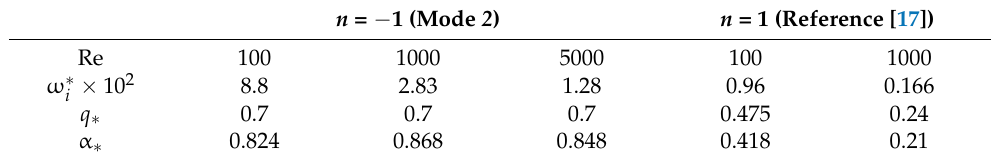
Figure 2. ( a ) The growth rate (solid lines) and oscillation frequency (dashed lines) vs. the wavenumber for Re = 100, q = 0.3; 0.4; 0.5; 0.6 (curves 1–4); the growth rate has a peak-like distribution. ( b ) Dependence of the growth rate from the swirl for α = 0.3, Re = 300, 1000, 5000, 10,000 (curves 1–4). Table 4. Comparison of viscous modes.